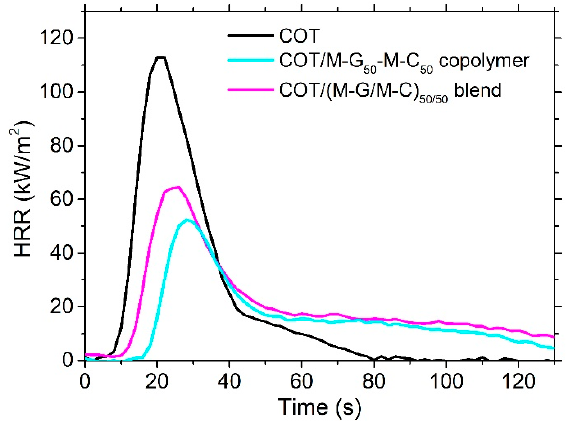
Figure 9. HRR curves of untreated, cotton fabrics treated with the M–G 50 –C 50 copolymer (add-on: 16.0%) and (M–G/M–C) 50/50 blend (add-on: 16.5%) by cone calorimetry tests. Table 7. Combustion data of untreated and cotton fabrics treated with M–G 50 –C 50 copolymer and (M– G/M–C) 50/50 blend by cone calorimetry tests.